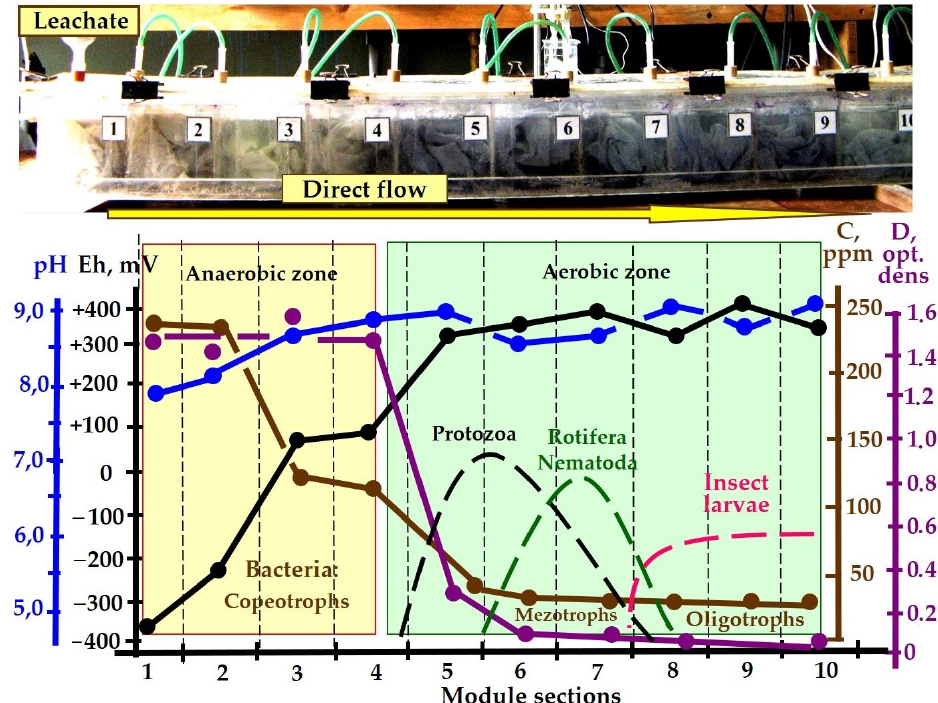
Figure 5. The overview of the air tank and variation in the levels of pH, Eh, total organic carbon, and optical density (540 nm) across individual sections harboring spatially separated communities of aerobic bacteria, Protozoa, invertebrates (rotifera, nematodes), and insect larvae.